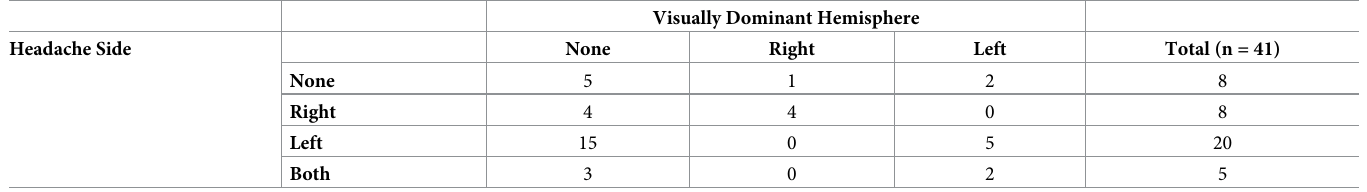
Visually Dominant